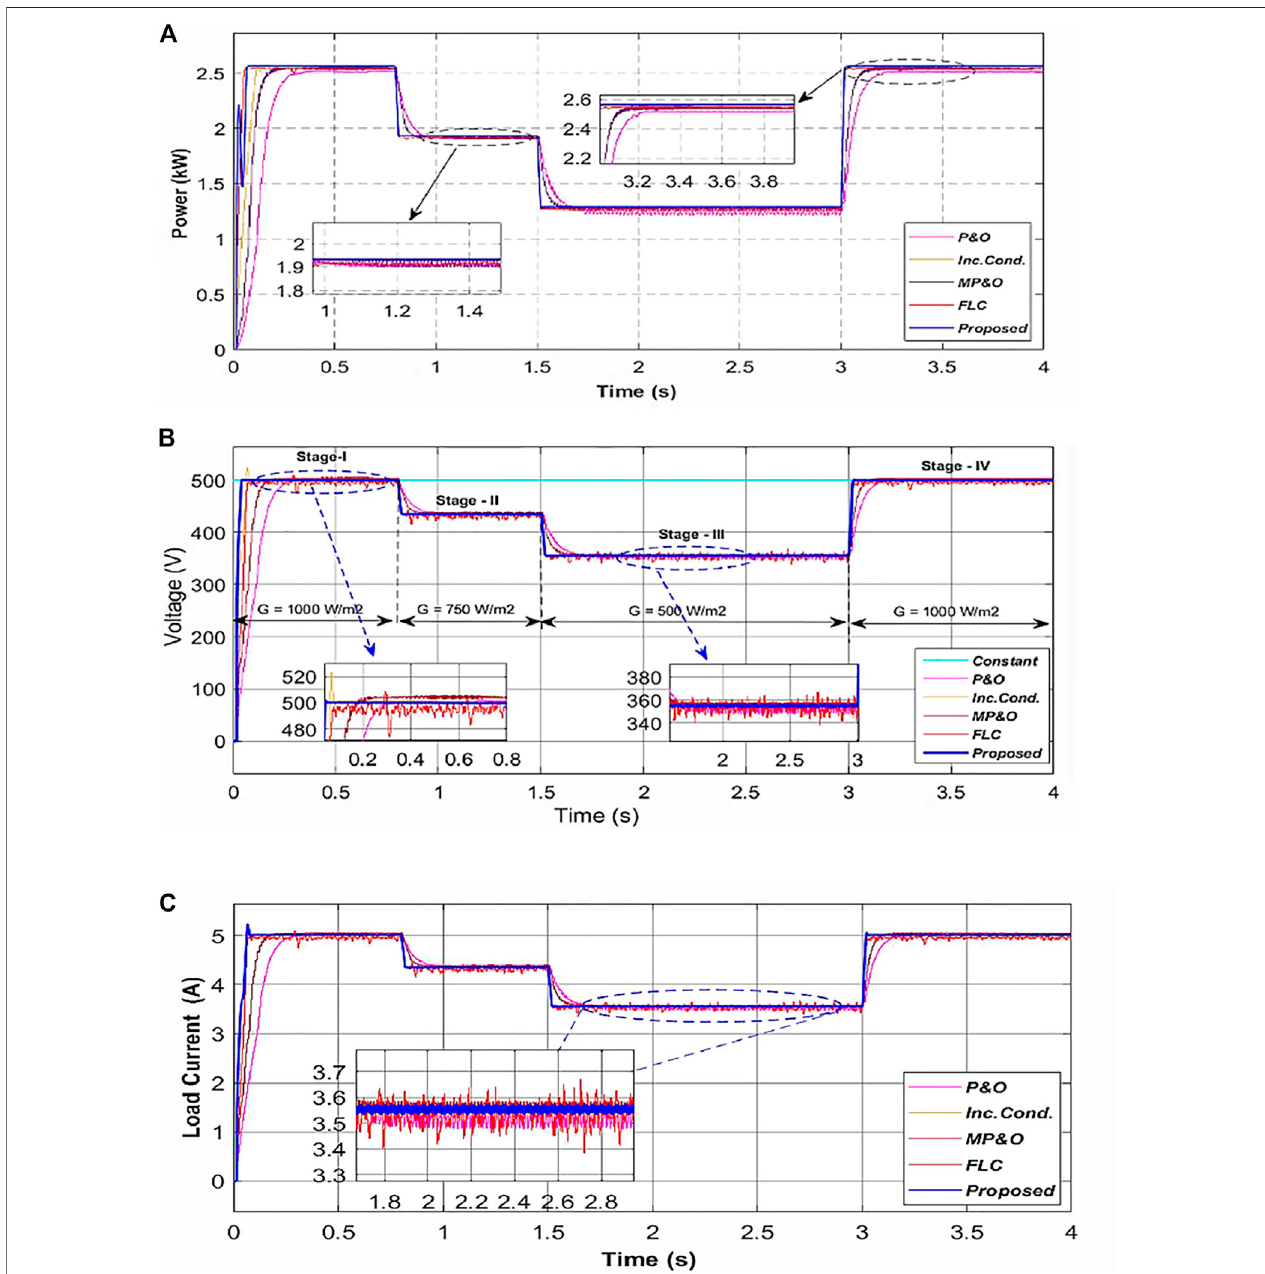
FIGURE 8 | Responses under Scenario-I: (A) Output power P 0 (B) output voltage, V 0 and (C) load current, I 0 .